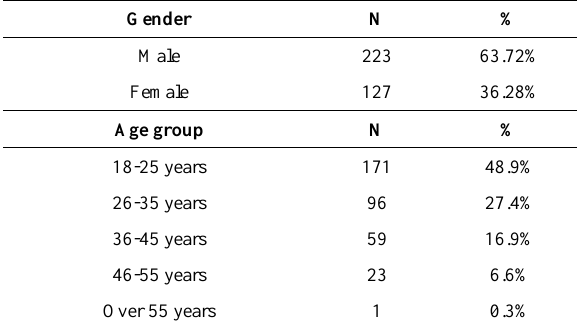
Table 2. Descriptive statistics of